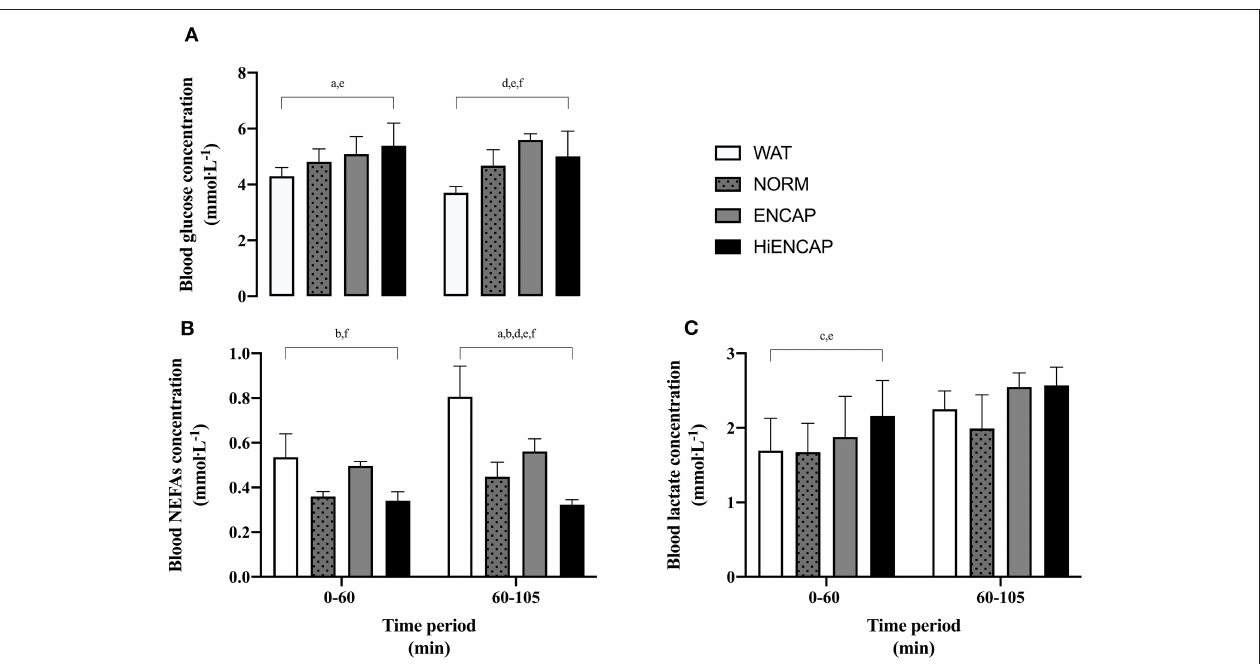
FIGURE 4 | Blood glucose (A) , serum NEFAs (B) , and blood lactate (C) over the 105-min run between WAT (white), NORM (dotted gray), ENCAP (gray), and HiENCAP (black). a = significant difference between NORM and WAT, b = significant difference between NORM and ENCAP, c = significant difference between NORM and HiENCAP, d = significant difference between WAT and ENCAP, e = significant difference between WAT and HiENCAP, and f = significant difference between ENCAP and HiENCAP. Blood glucose n = 5 and serum NEFAs and blood lactate n = 7. Values are mean ± SD.